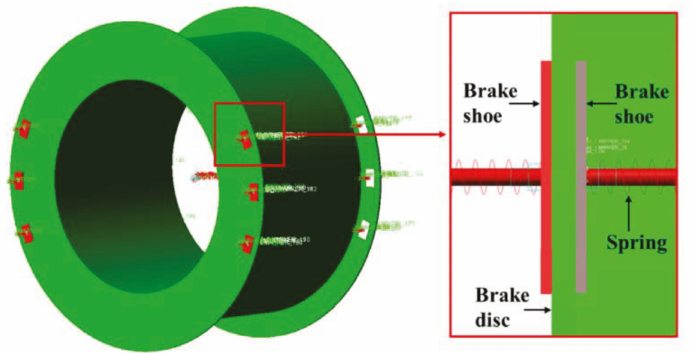
Figure 3. Dynamic model of the disc brake of a deep coal mine hoisting